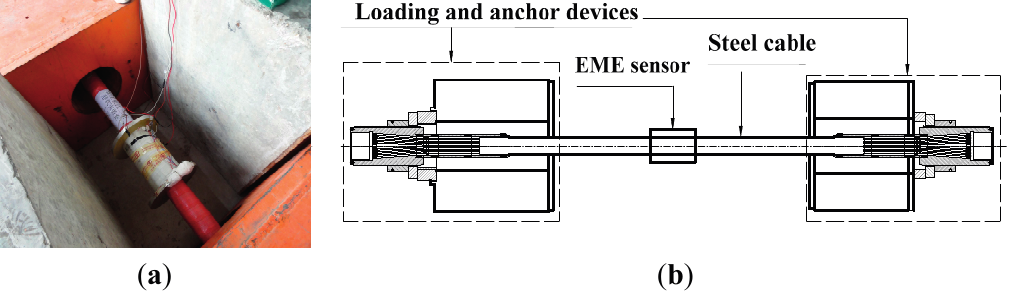
Figure 9. The setup of the full-scale experiment for the performance tests of the EME sensor: ( a ) Photo; and ( b ) Schematic diagram.